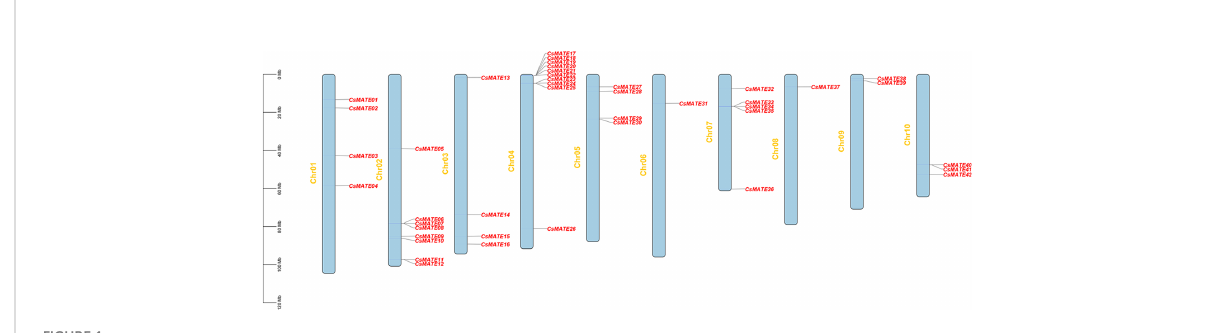
(Table 1). The isoelectric points (pI) and molecular weights (MW) of CsMATEs range from 5.12 – 9.56 and 35.38 – 68 kilodalton (kDa), respectively (Table 1). Thirty- fi ve CsMATEs were localized in the plasma membrane, six in the vacuole, and only CsMATE39 localized in the chloroplast (Table 1). CsMATEs, we constructed an interspecifc phylogenic tree using C. sativa and A. thaliana MATEs sequences with phylogenetic inference of neighbor-joining (Figure 2). The topology of the phylogenic tree divides CsMATEs into four major subfamilies. Subfamily I contains 14 CsMATEs, subfamily